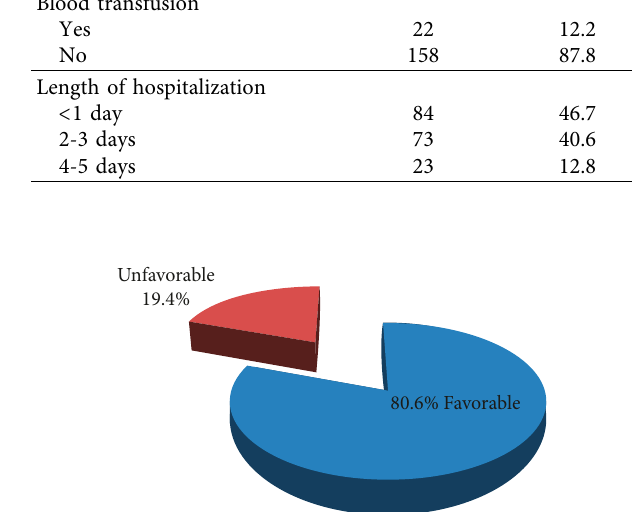
Figure 1: Management outcomes of incomplete abortion at Yir- galem General Hospital, Sidama zone, southern Ethiopia, from 1 st July 2015 to July 30 th